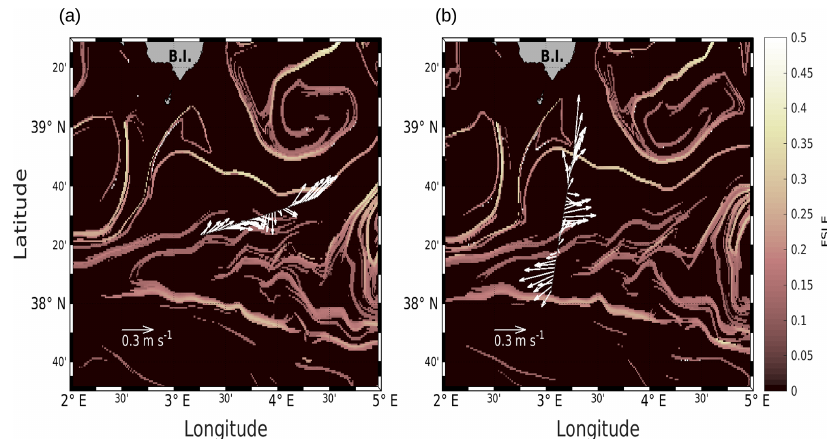
Figure 2. Horizontal velocities measured by VMADCP at 25m, along the WE (a) and NS (b) transects, superimposed onto the FSLE field for the corresponding date (i.e., 9 and 11 May 2018, respectively). Unit for FSLE is d − 1 .